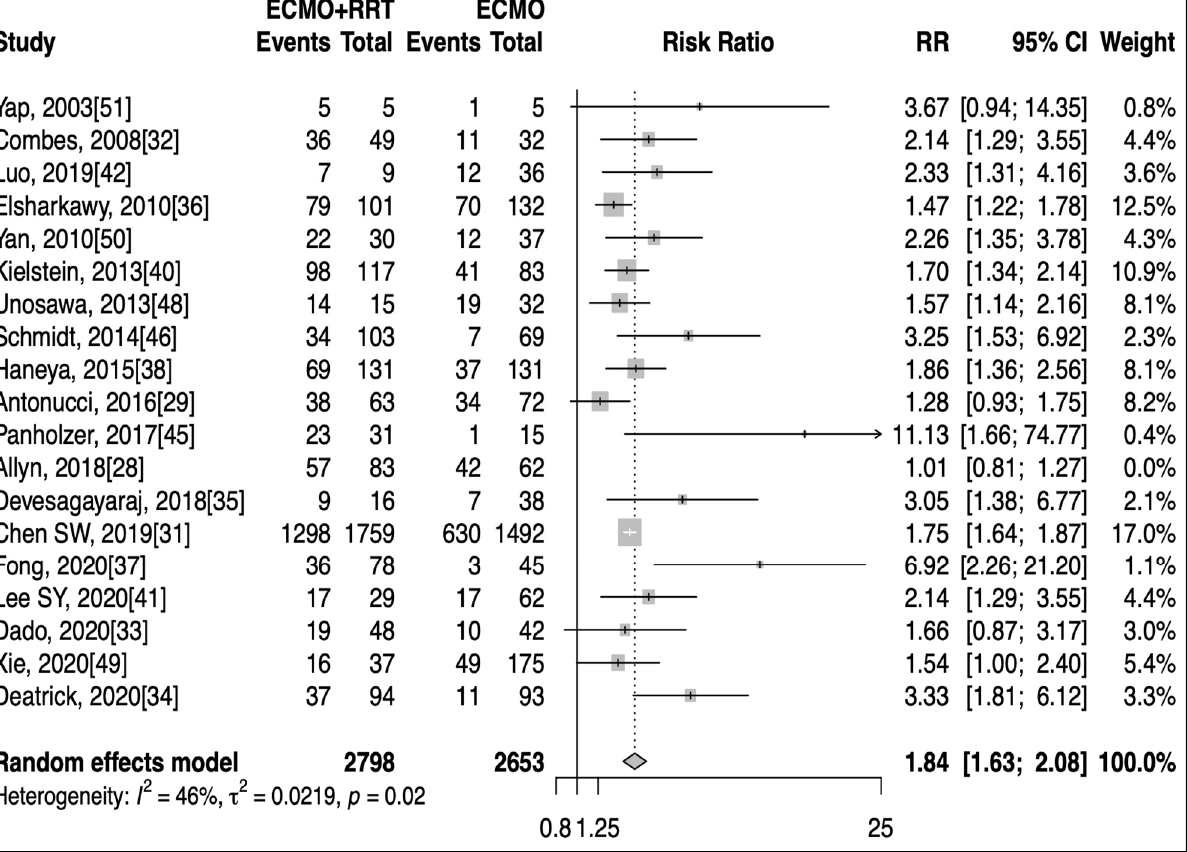
Figure 2. Forest plot showing increased risk of mortality in patients receiving combined therapies (ECMO: extracorporeal membrane oxygenation, RRT: renal replacement therapy).